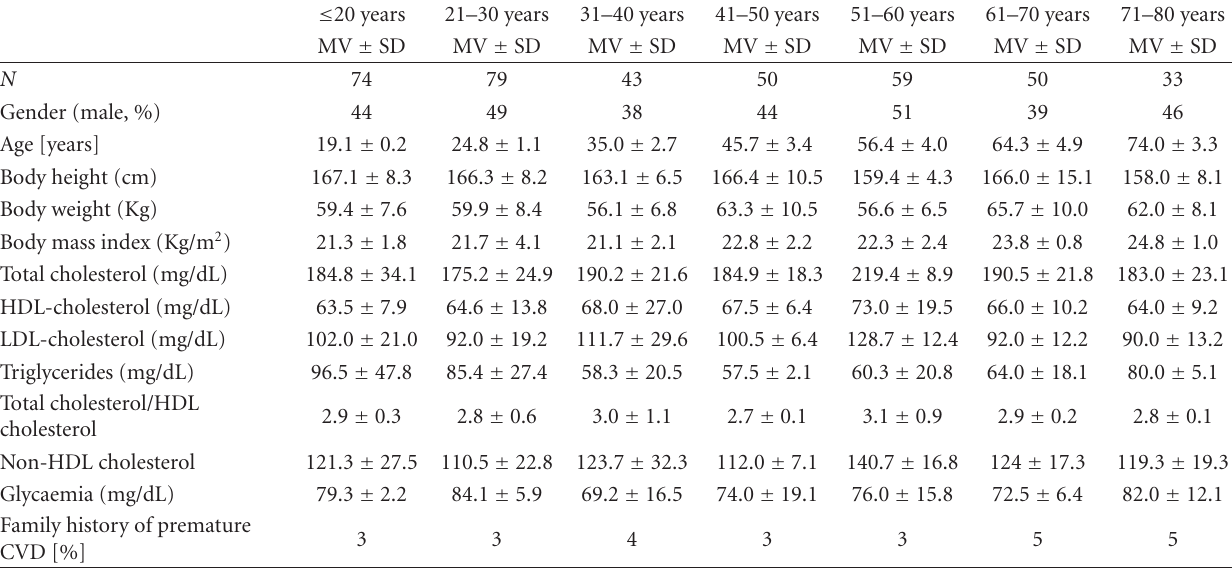
Table 1: Anthropometric and biochemical measurements of the seven di ff erent age